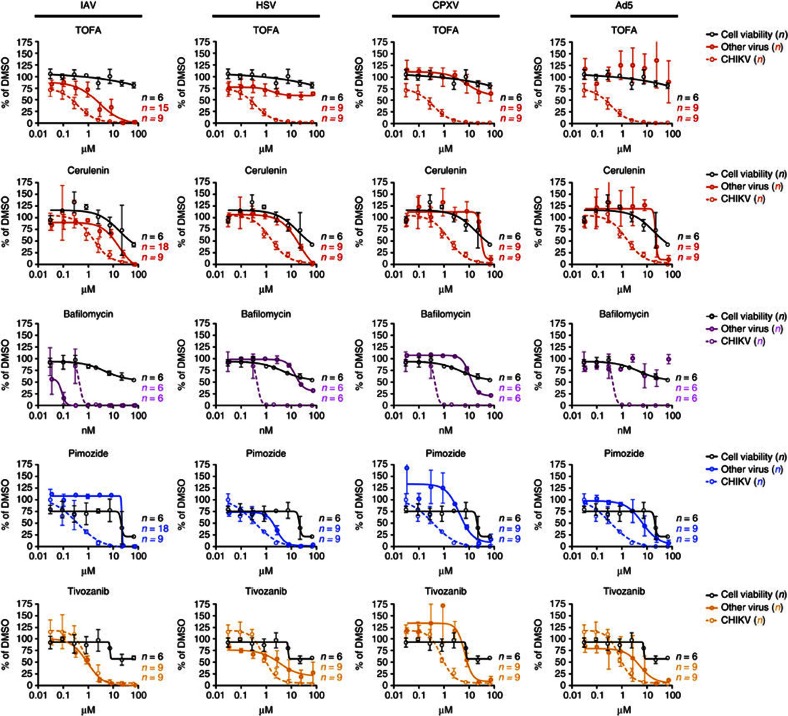
Effect of the identified antiviral drugs on different classes of viruses.Dose–response curves (coloured solid lines) performed on HEK-293 cells or A549 cells (in case of IAV infection), pretreated for 2 h with the indicated drugs and then infected with distant classes of viruses. Black solid lines and coloured dashed lines indicate the corresponding dose–response curves determined for cell viability and CHIKV infection, respectively (Table 1; Supplementary Fig. 4). Data were obtained from the combination of at least two independent experiments (n is indicated in each panel) and are depicted as mean±s.e.m. for each point.